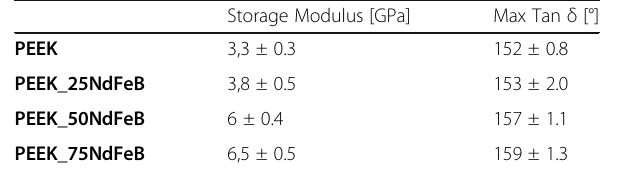
Table 4 PEEK_NdFeB filaments: DMTA results